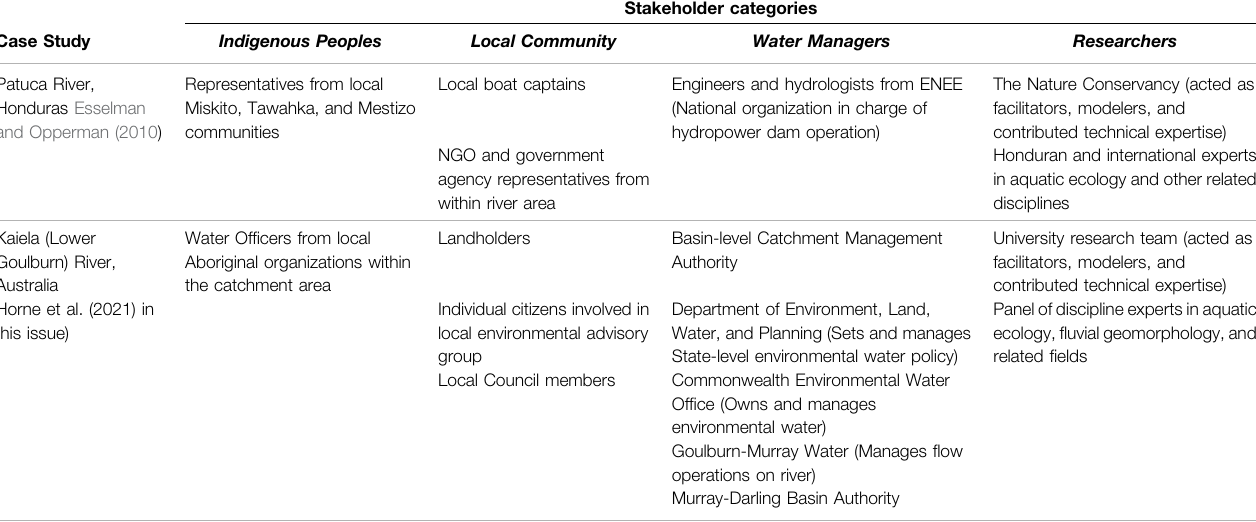
TABLE 1 | E- fl ows case studies with participants grouped into stakeholder